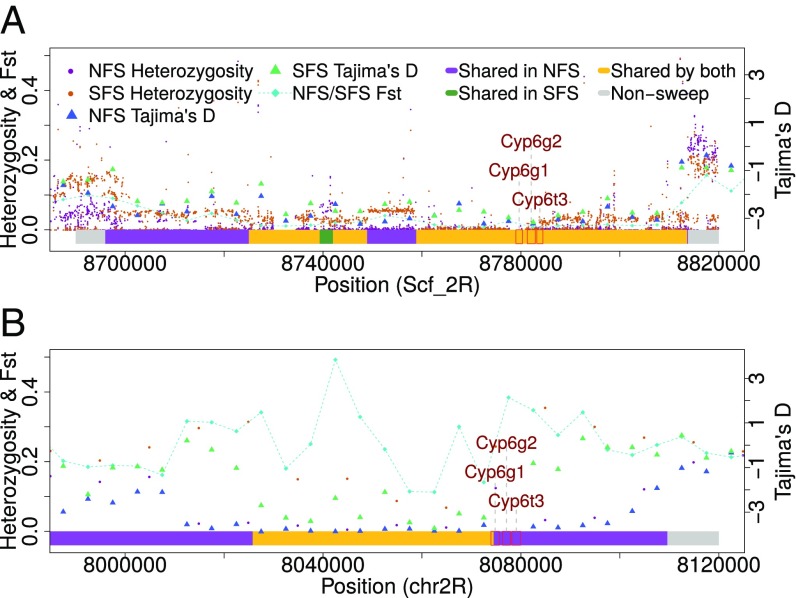
Steep decline of heterozygosity (based on 100-bp windows), Tajima’s D values on a chromosomal arm 2R region (8,700,000–8,820,000) in D. simulans (A), and the corresponding region (chr2R 8,000,000–8,120,000) in D. melanogaster (B). Colors used correspond to sweep regions as in Fig. 1.